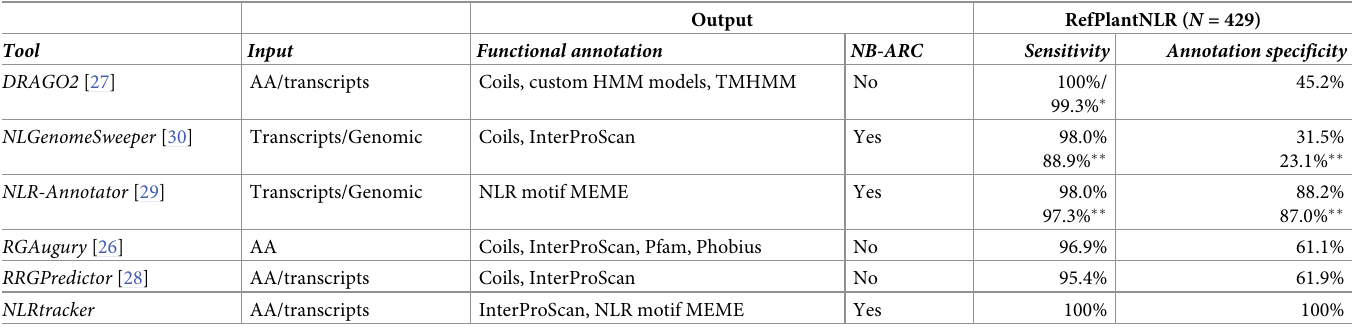
Table 1. NLR annotation